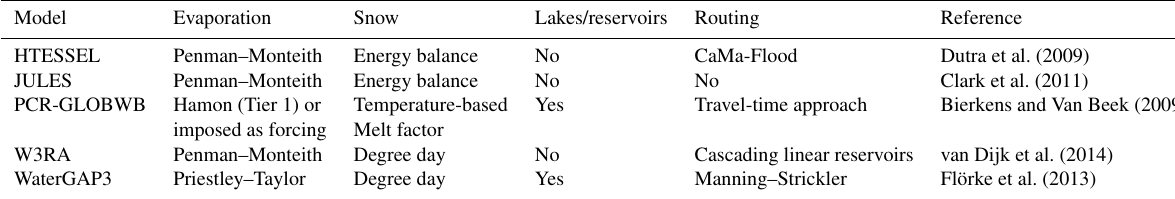
Table 2. Global model and process summary.